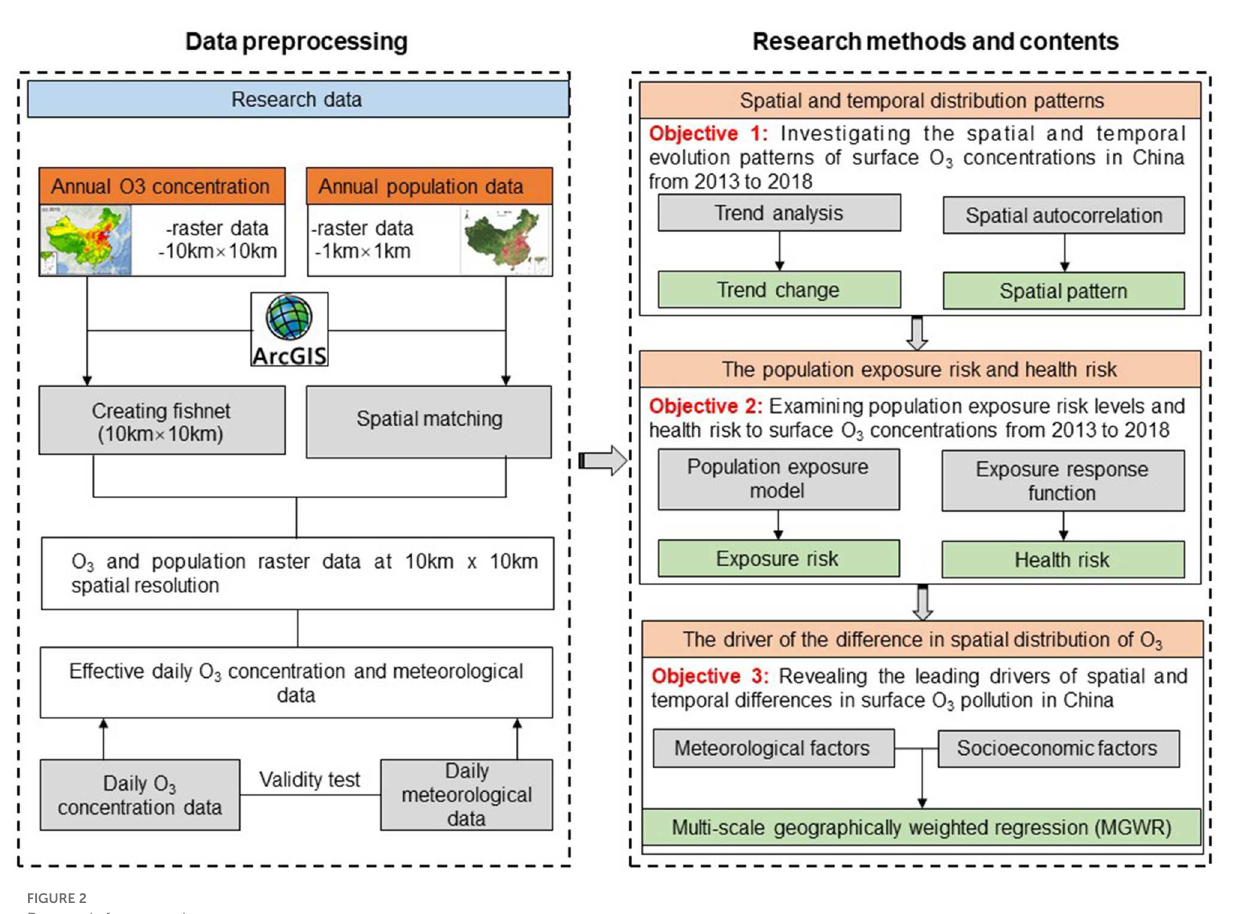
FIGURE2 Research